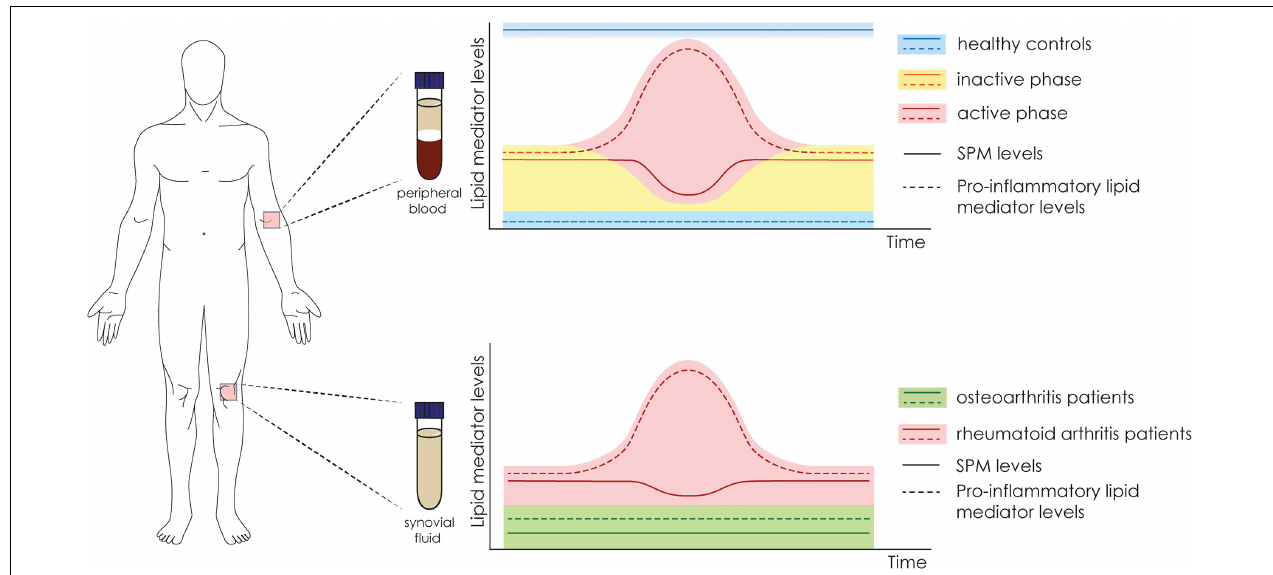
FIGURE 1 | Fluctuation in the levels of SPMs and pro-inflammatory mediators in human samples of serum and synovial fluid. Schematic representation of the fluctuation in the levels of lipid mediators according to the authors’ interpretation. In serum samples of healthy controls (in blue), there are high levels of SPMs and low levels of pro-inflammatory mediators. In arthritic patients, the levels of SPM fluctuate according to the disease phase, which varies between inactive (yellow) and active (red). In the synovial fluid (bottom panel), the levels of SPMs are higher in RA patients (red) in comparison to osteoarthritis patients (green). In contrast, the levels of pro-inflammatory mediators are also higher in RA patients, especially in the active